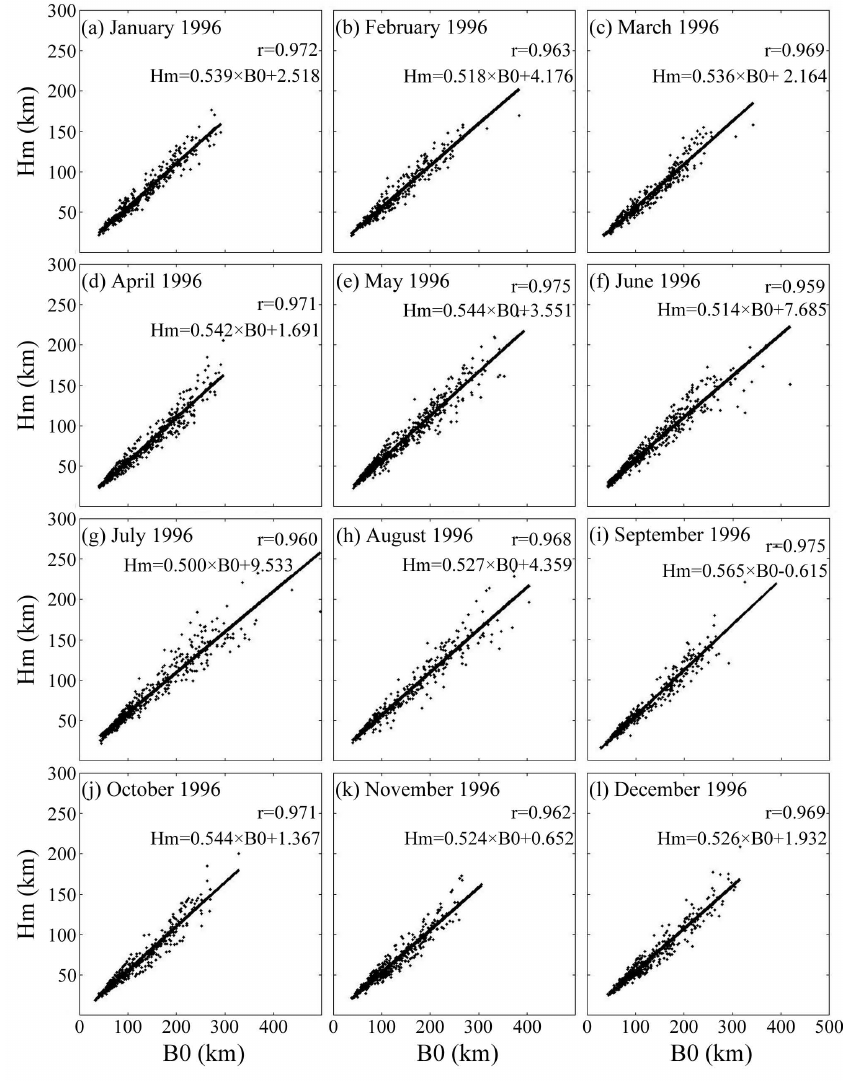
Fig. 8. The scatter plots of Hm versus B0 during January–December 1996. The correlation coefficient ( r ) of Hm and B0 and the equation of least-squares straight line (solid line) for each month are placed in the upper-right